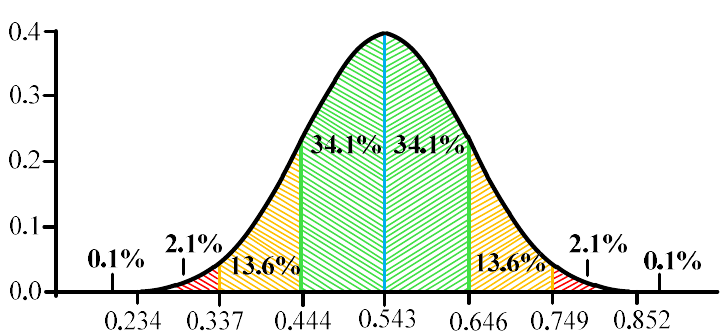
Figure 27. Range of values (-3SN;+3SN) for normal UDP traffic for monitoring windows = 15 seconds.